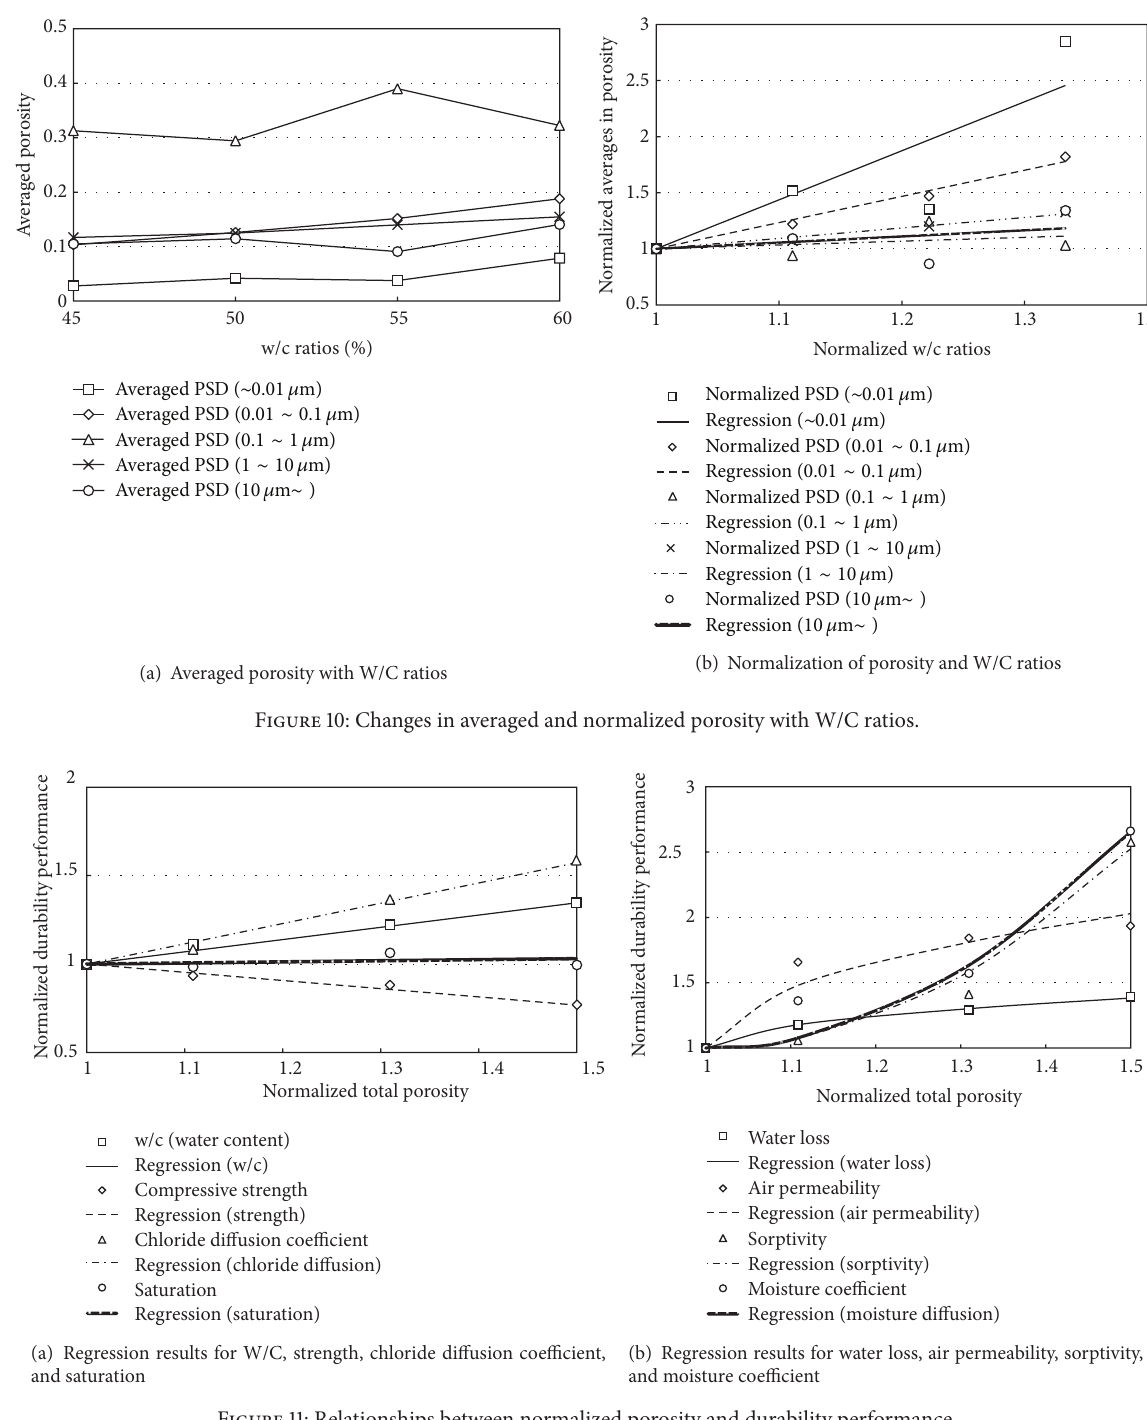
Figure 11: Relationships between normalized porosity and durability